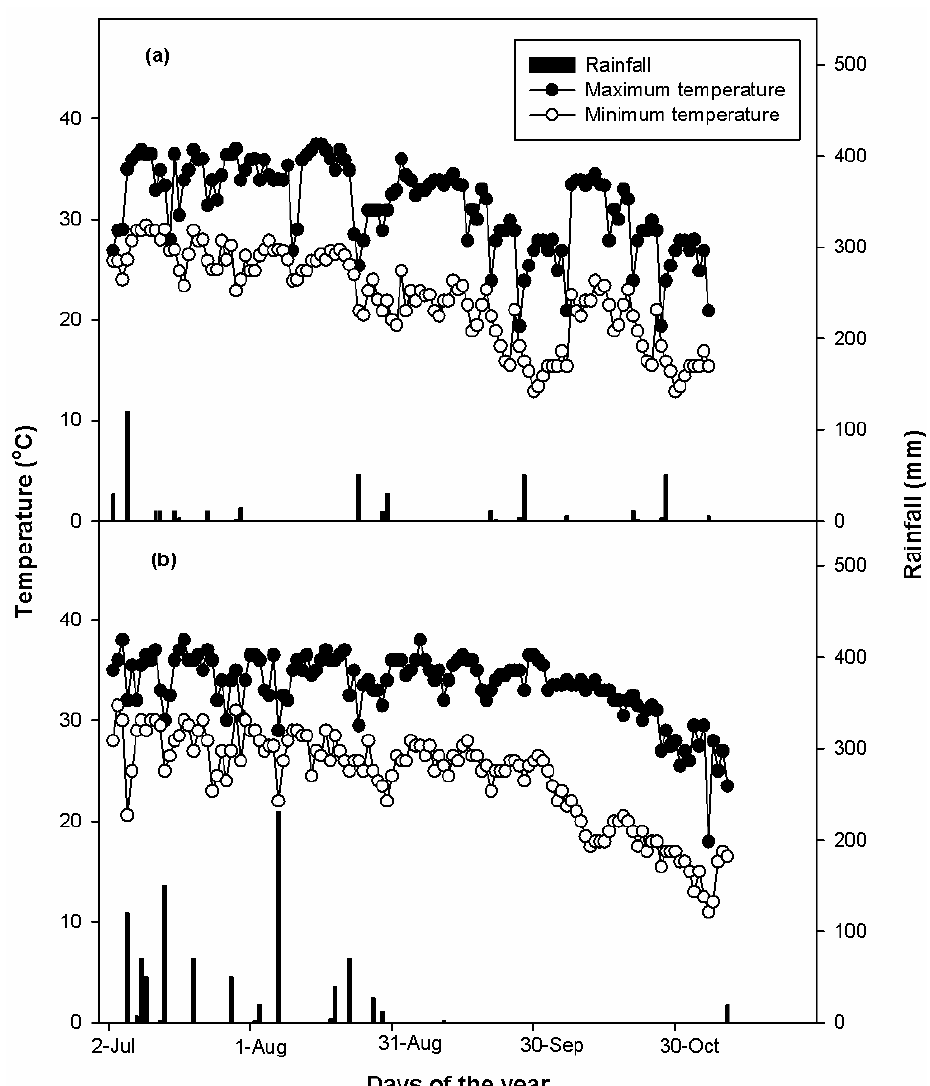
Figure 1. The daily maximum or minimum temperatures and rainfall during the maize growing seasons of the experimental site in 2017 ( a ) and 2018 ( b ).